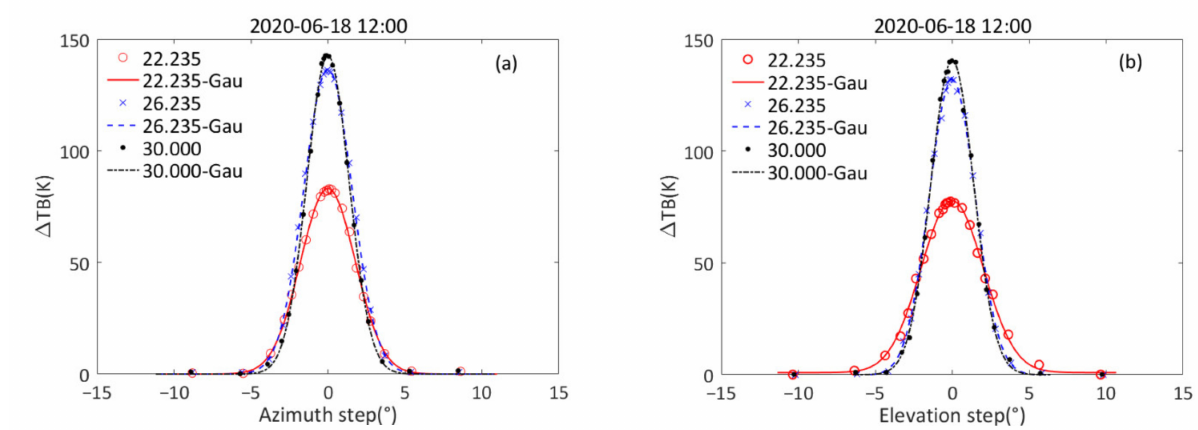
Figure 5. An example of the solar scanning observation on 18 June 2020, 12:00 a.m. (local time). The angle distortion was calibrated. The solar elevation was 78.1 ◦ .The markers are for the observed TB increments and the lines are for fitting with the Gaussian function by using the least-square method. The origin represents the center of the sun. ( a ) Azimuth scanning and ( b ) elevation scanning.